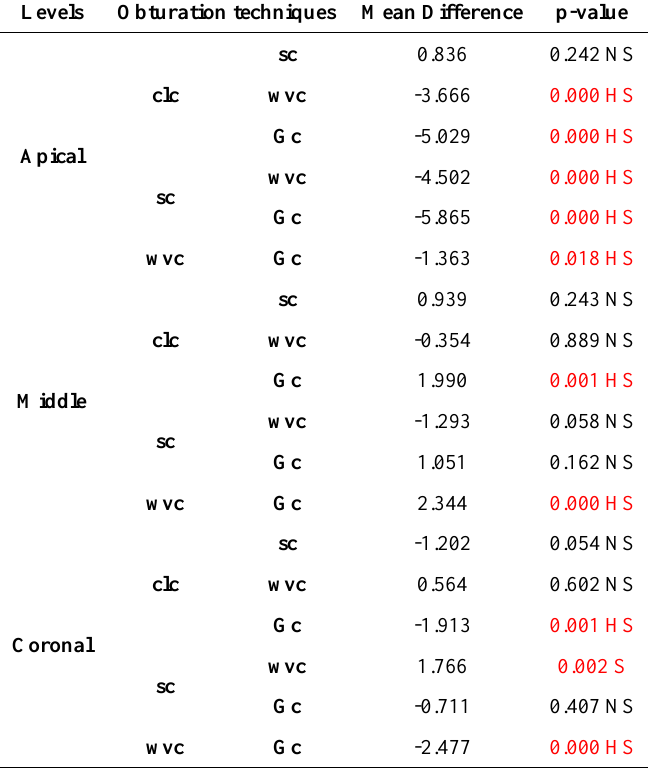
Table (2): Multiple comparisons among different obturation techniques using Tukey's HSD test